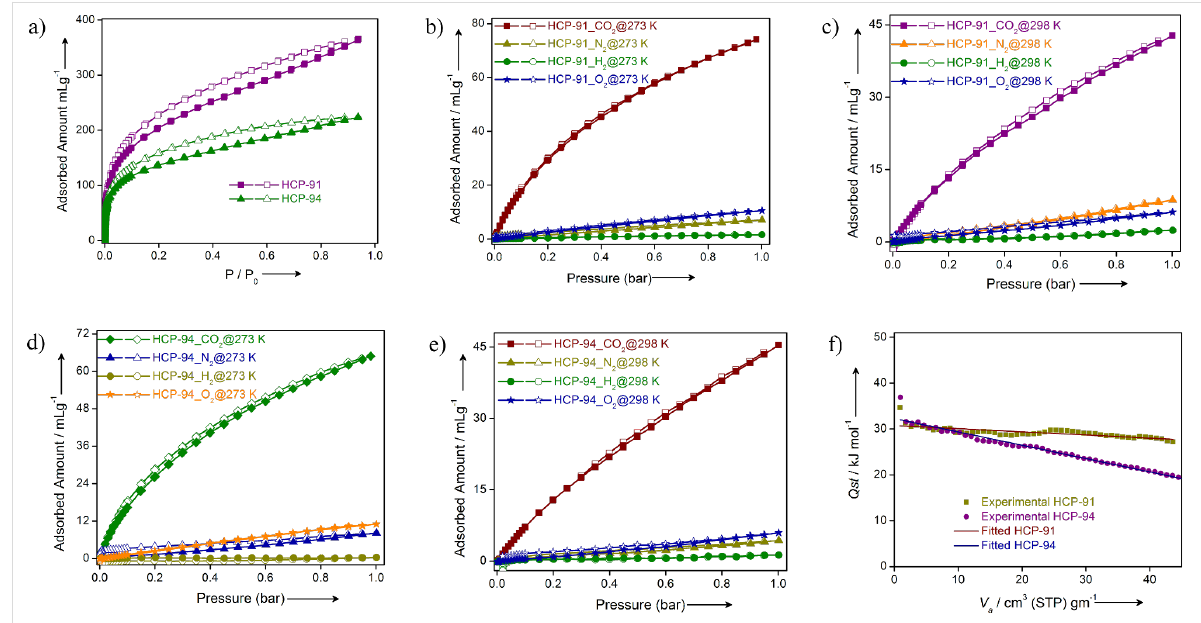
Figure 3: a) CO 2 adsorption isotherms for HCP-91 (purple) and HCP-94 (green) at 195 K; b) adsorption isotherms of CO 2 (wine red), N 2 (dark yellow), H 2 (green) and O 2 (blue) for HCP-91 at 273 K; c) adsorption isotherms of CO 2 (purple), N 2 (orange), H 2 (green) and O 2 (blue) for HCP-91 at 298 K; d) adsorption isotherms of CO 2 (green), N 2 (blue), H 2 (dark yellow) and O 2 (orange) for HCP-94 at 273 K; e) adsorption isotherms of CO 2 (wine red), N 2 (dark yellow), H 2 (green) and O 2 (blue) for HCP-94 at 298 K and f) Q st plots for HCP-91 (dark yellow) and HCP-94